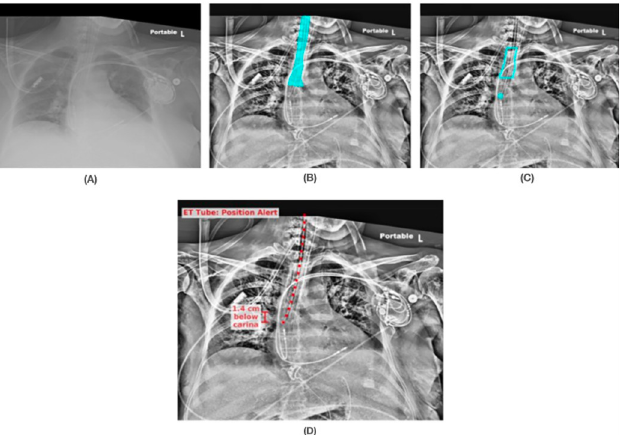
Fig 9. Visual example of nodes leading to determining correct ETT placement, determined by knowledge- supported machine reasoning. (A) Original chest x-ray image; (B) trachea region overlayed on an enhanced image; (C) ETT safe zone ( et_zone ) and tube tip location ( et_tip ) showing the tip outside the safe zone; (D) the final output of the system as presented to the physician with the red overlay indicating the system determination of incorrect tube placement (tip too low relative to the